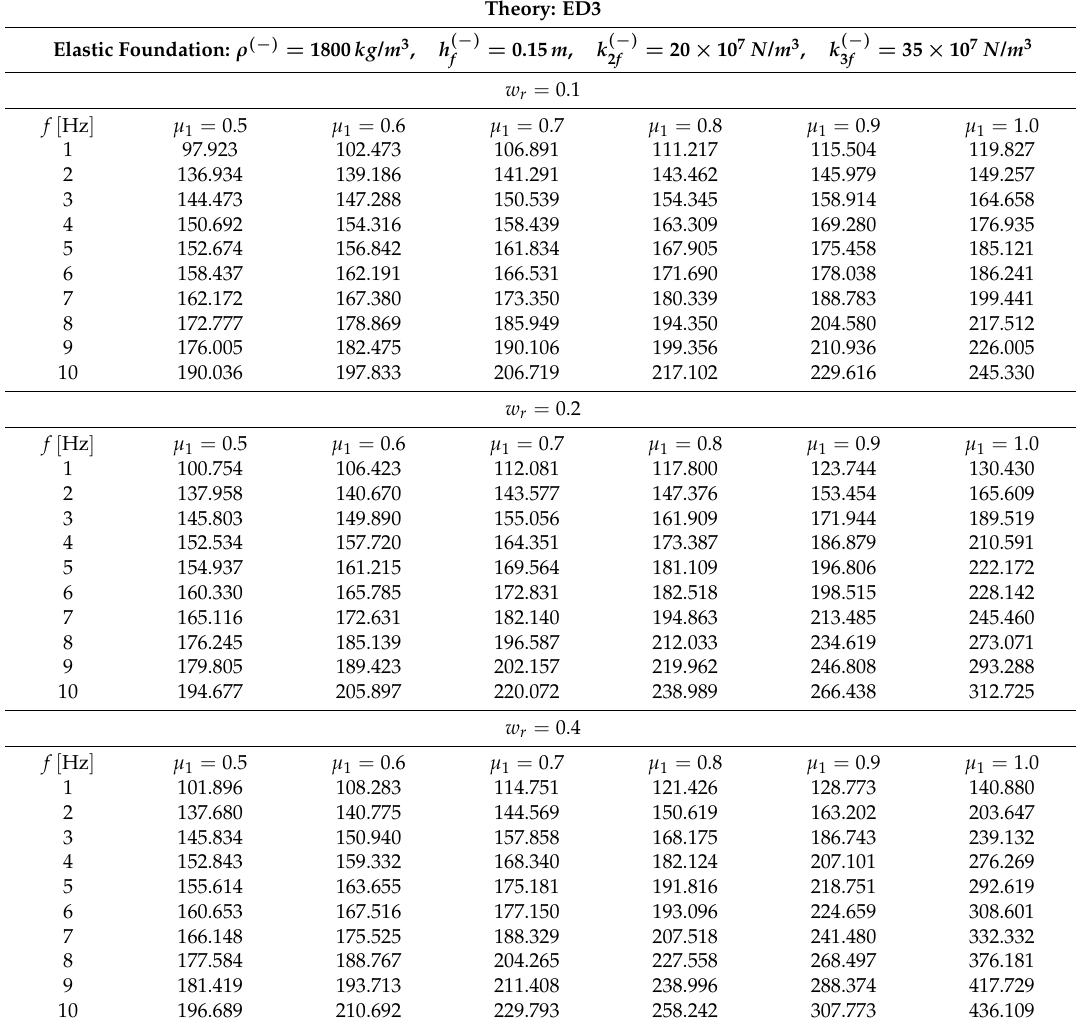
Table 14. First ten natural frequency variations for ED3 theory of a CCFF helicoidal surface (Figure 4c) reinforced by CNTs distributed as in Figure 5c for different mass fractions w r when varying the parameter of agglomeration µ 1 with µ 2 = 1. The Chebyshev-Gauss-Lobatto grid distribution was employed, with I N = 31, I M =